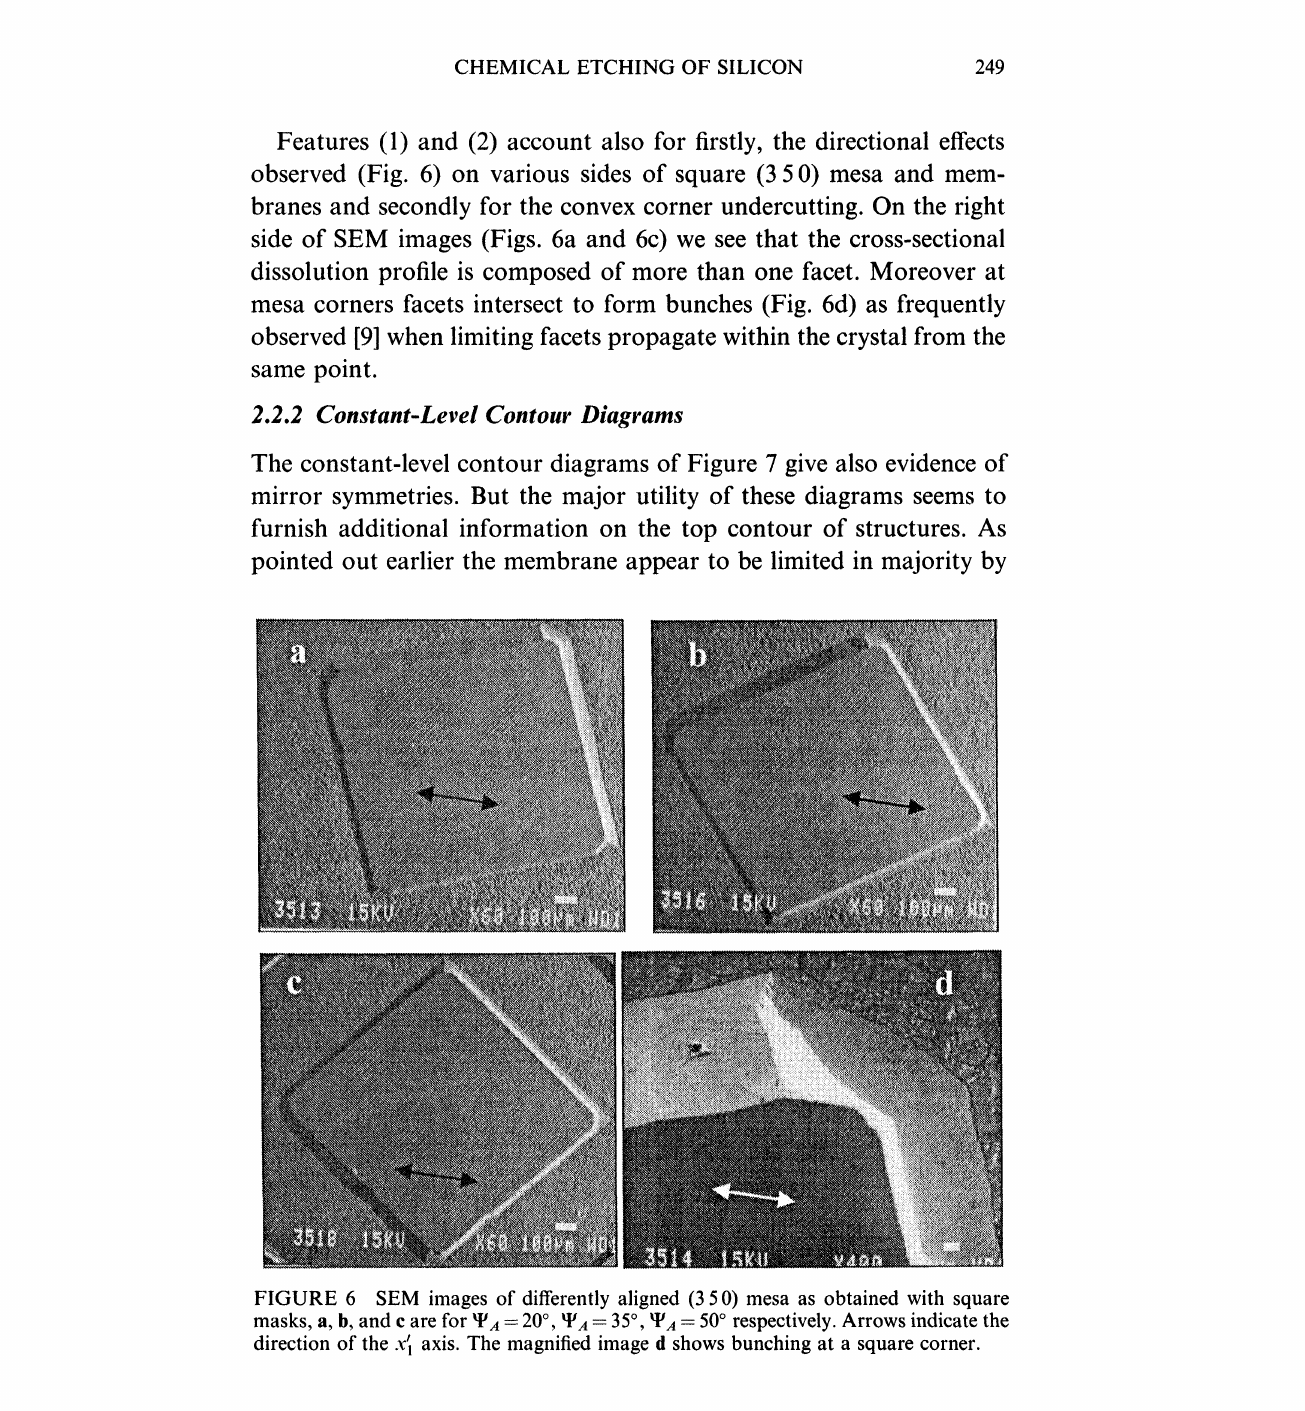
, , FIGURE 6 SEM images of differently aligned (3 50) mesa as obtained with square qa 35 qA 50 respectively. Arrows indicate the masks, a, b, and e are for Wa 20 x direction of the axis. The magnified image d shows bunching at a square